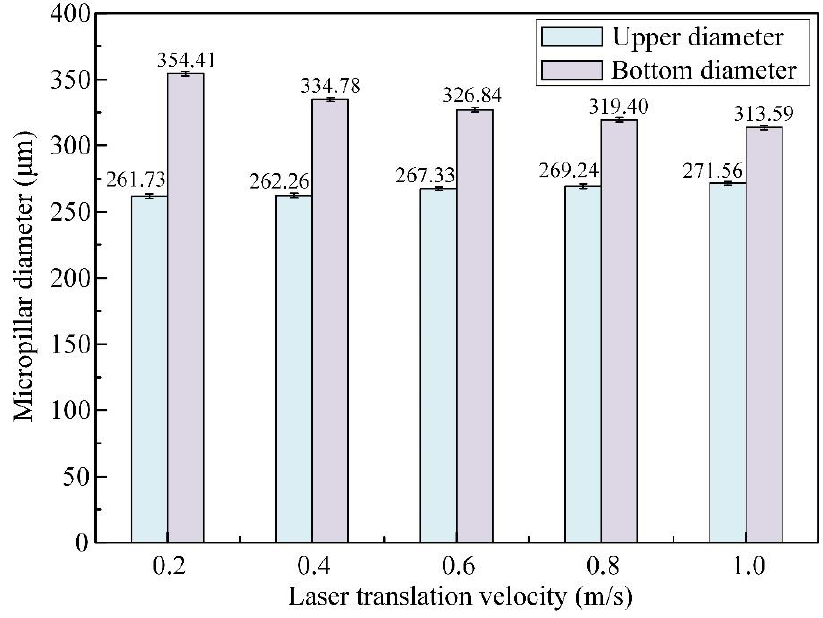
Figure 10. Influence of laser translation velocities on the average upper and bottom diameters of micropillars, with a pulse energy of 50 μJ and a pulsed repetition rate of 600 kHz.